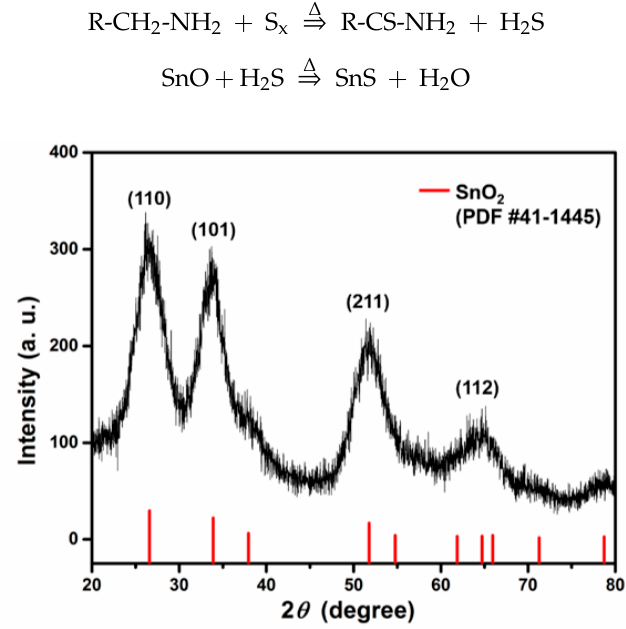
Figure 6. SEM image of SnCl 4 hydrolyzates and the element composition of the circled area measured by EDX.